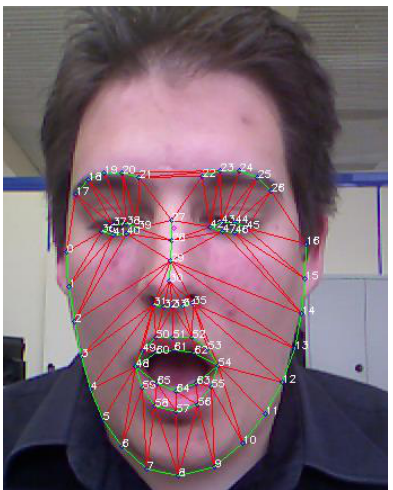
Figure 3. FaceTracker detects in real-time a set of 66 points. Points 0 to 16: lower facial contours, 17 to 21 and 22 to 26: right and left eyebrows, 27 to 35: nose, 36 to 41 and 42 to 47: right and left eyes, 48 to 65: edge of lips .